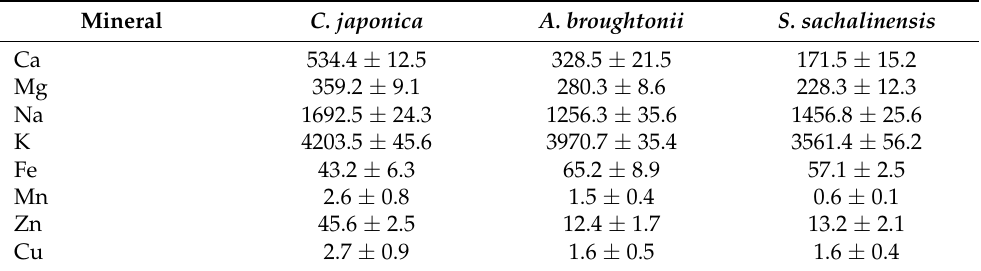
Table 3. Mineral content of the tissue of bivalve mollusks ( µ g/g wet weight).